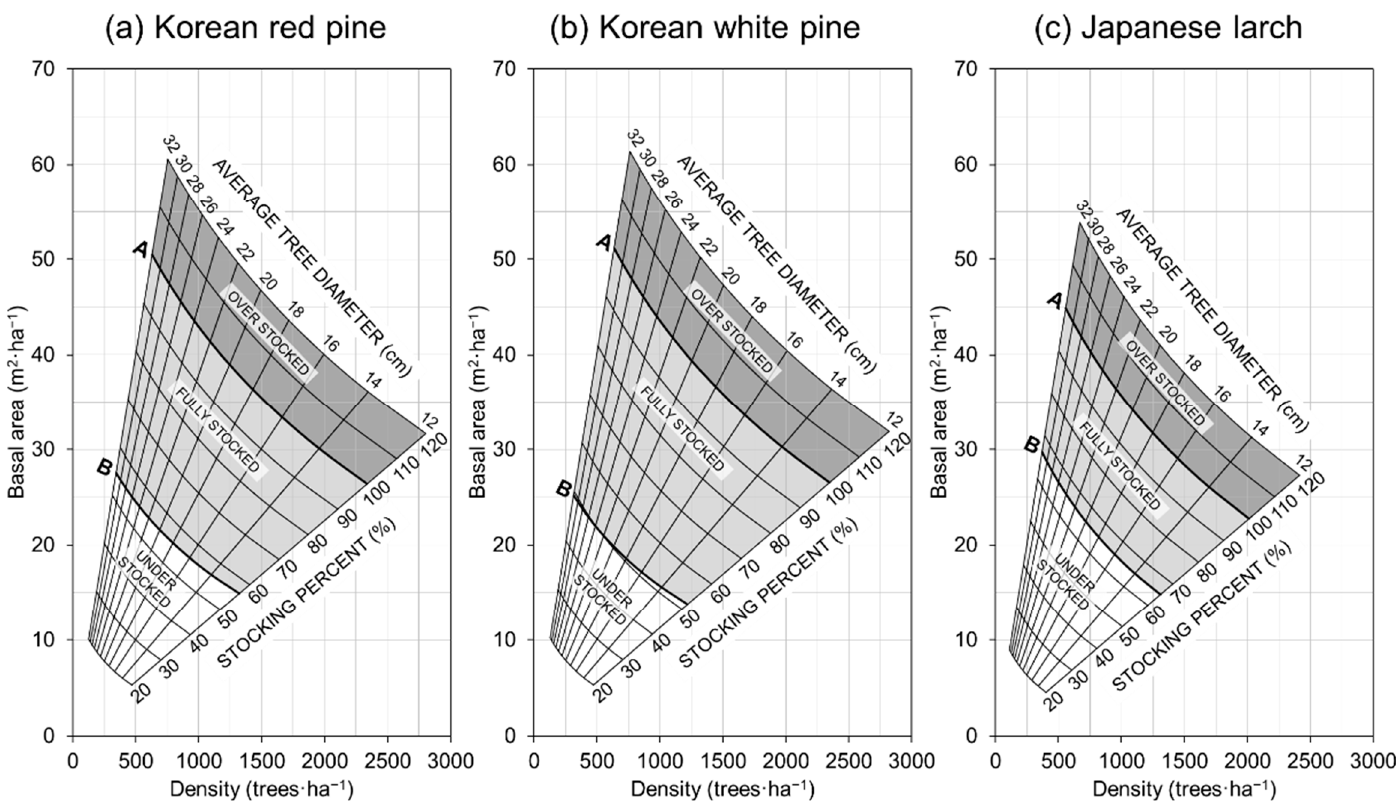
Figure 5. Stand density management diagrams showing relationships among average tree diameter, number of trees per hectare, and basal area per hectare for ( a ) Korean red pine, ( b ) Korean white pine, and ( c ) Japanese larch. A-level stocking represents maximum density on fully stocked stand as boundary line between overstocked and fully stocked. B-level stocking represents minimum density on fully stocked stand as boundary line between fully stocked and understocked. Average tree diameter is quadratic mean diameter and covers range of small to large tree diameters in Korea.